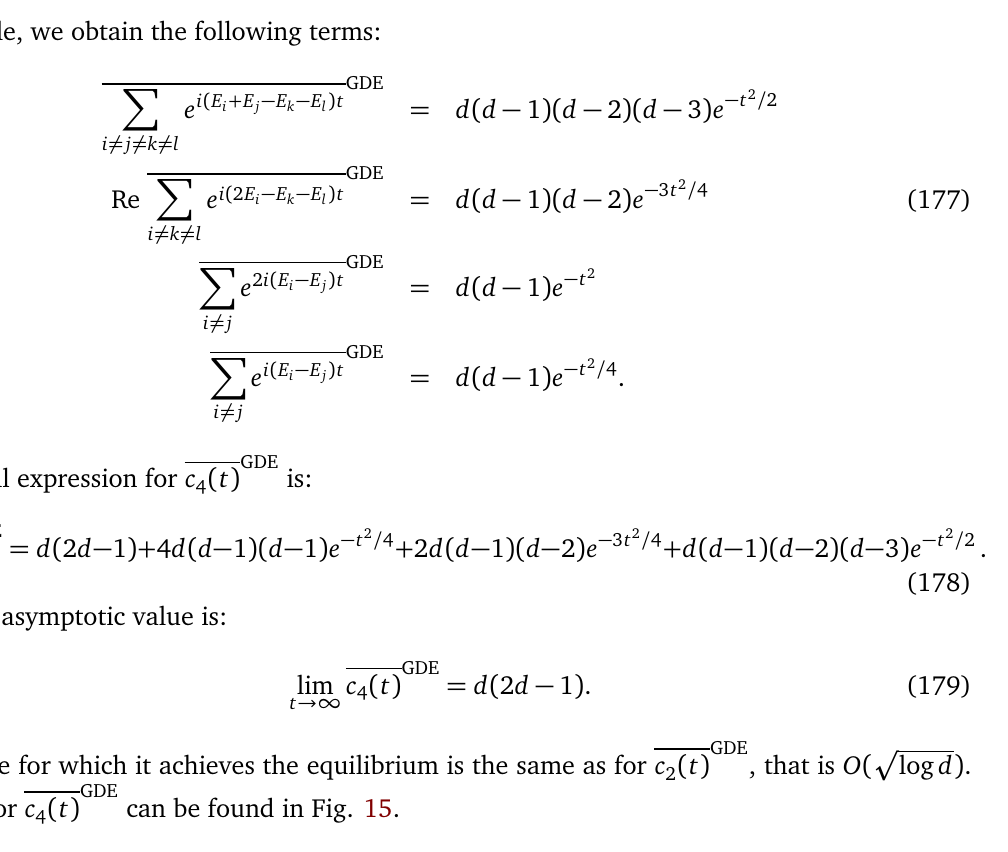
Figure 15: Left :Log Log plot of the normalized spectral function ˜ c averaged over the GUE ensemble for different system size d = 2 N with N = 6,...,16. Right : Log Log plot of the rescaled spectral function ˜ c the GDE ensemble for different system size d = 2 N with N =